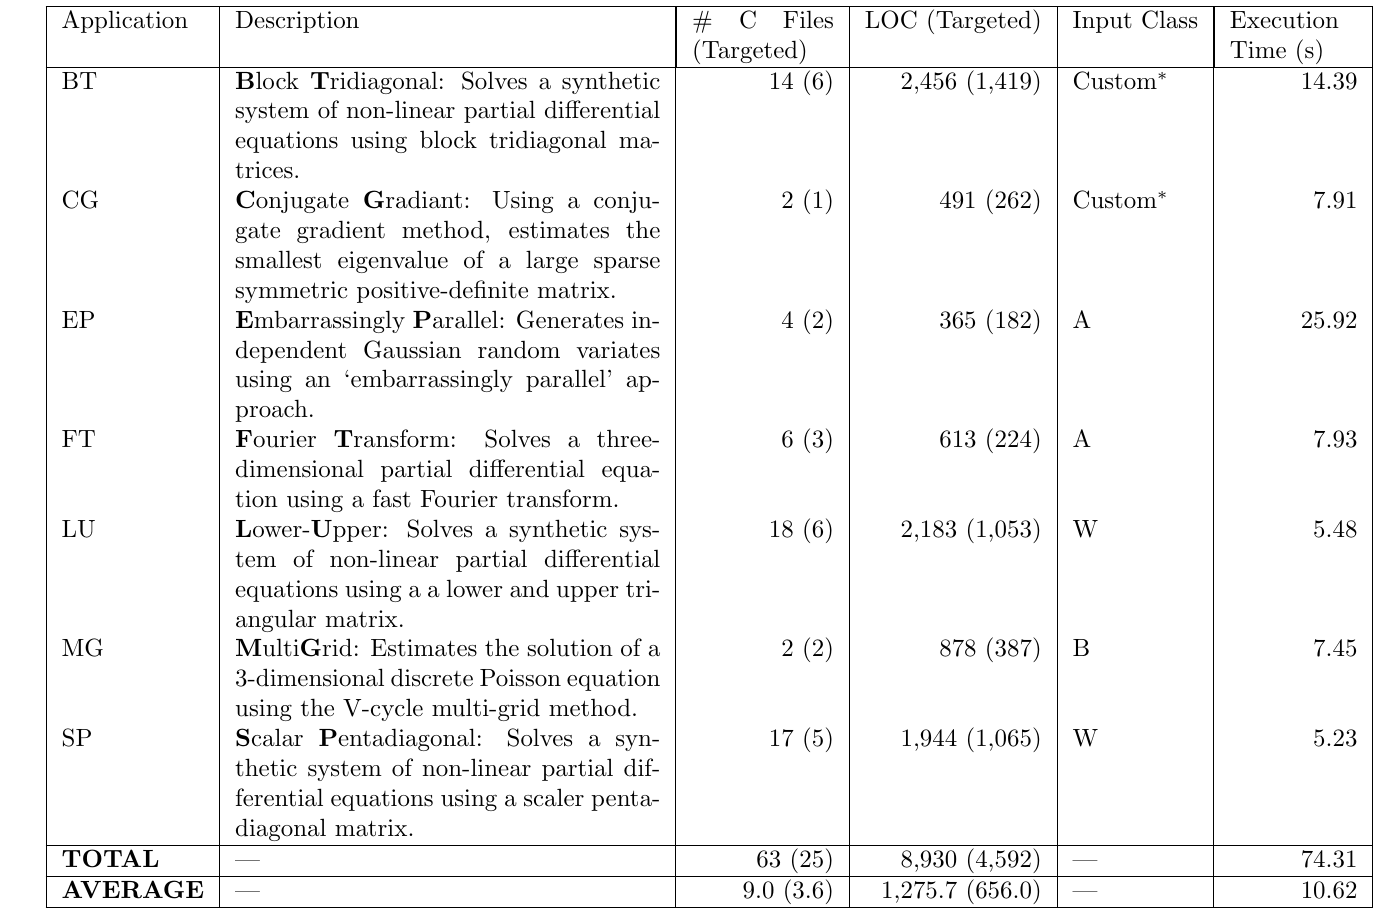
Table 1: The sequential applications within the NAS-NPB Suite, showing the number of C files, line of code, input class used, and execution time. Files and lines targeted by our approaches are in parenthesis. ∗ Custom input classes defined in